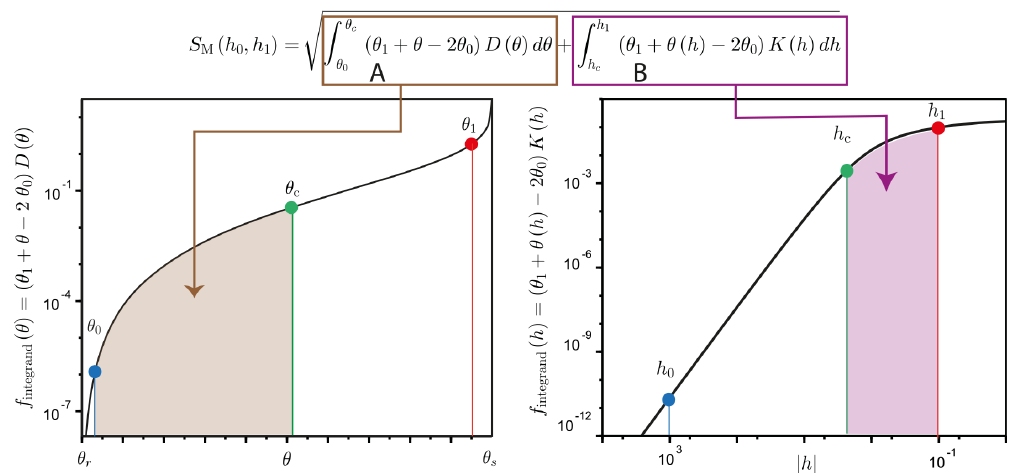
h 1 (cid:82) (θ 1 + θ(h) − 2 θ 0 )K(h)dh ( = S 2 (h 0 ,h 1 ) ) is converted into the M h 0 h 1 θ c (cid:82) (cid:82) (θ 1 + θ − 2 θ 0 )D(θ)dθ and (θ 1 + θ(h) − 2 θ 0 )K(h)dh . Note that the θ 0 h c